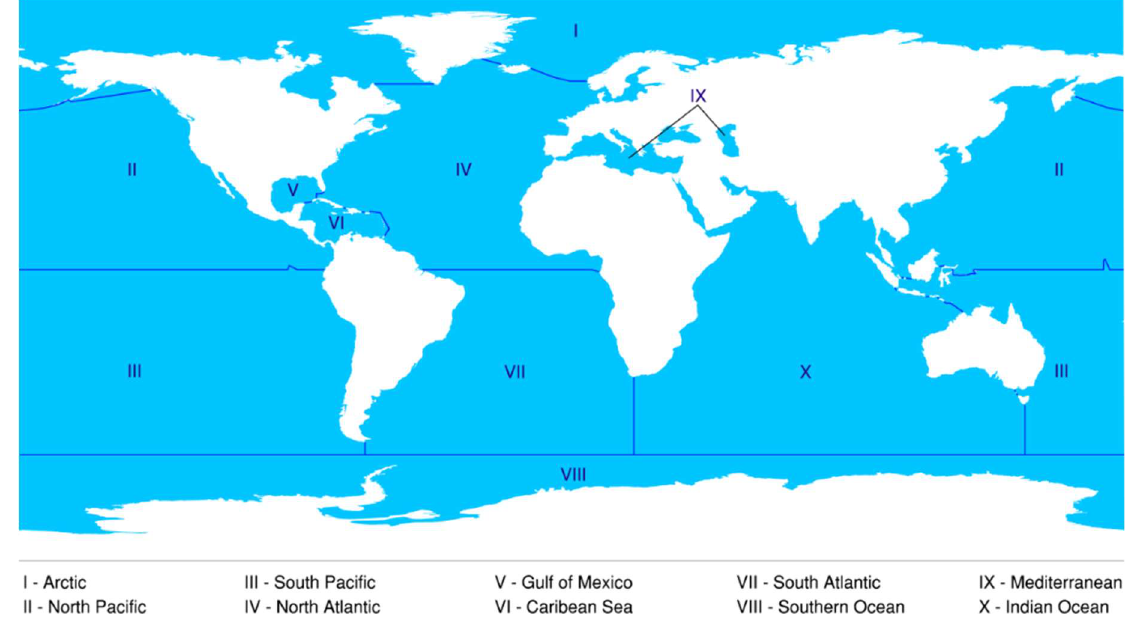
Figure 2. Ten marine regions delimited for analysis of the spatial distribution of marine geohazard surveys.